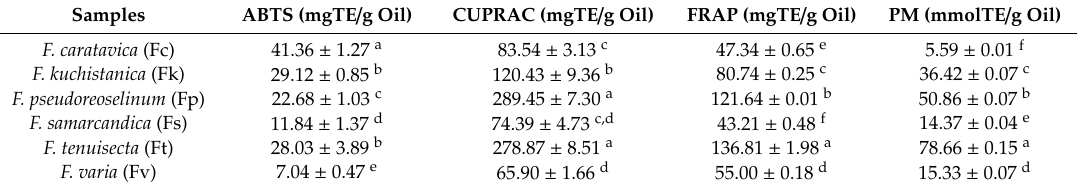
Antioxidant activities of the essential oil samples of Ferula species using the 2,2 (cid:48) -azino-bis(3-ethylbenzothiazoline-6-sulfonic acid) (ABTS), the cupric ion reducing antioxidant capacity (CUPRAC), The ferric reducing antioxidant power (FRAP) and the phosphomolybdenum method (PM)